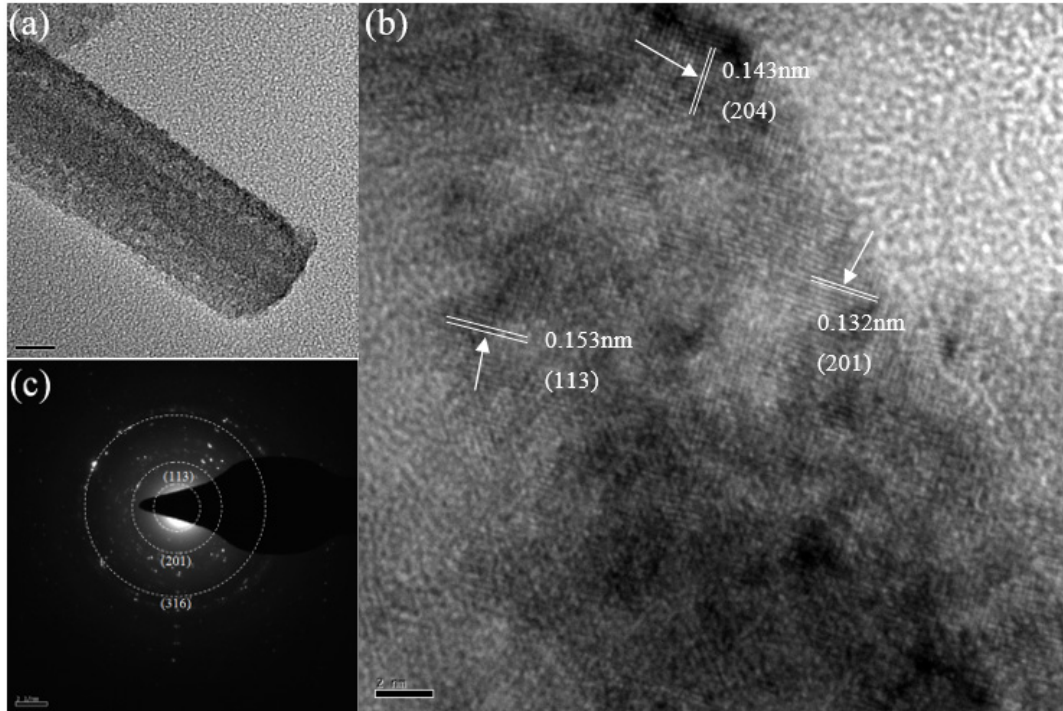
Figure 5 . ( a ) TEM image, ( b ) HRTEM image, and ( c ) SAED pattern of Ni 4 Co 4 Fe 2 -LDH/NF. The surface chemical state of Ni 4 Co 4 Fe 2 -LDH/NF was investigated by XPS technique (see Figure 6). As shown in Figure 6, XPS results confirm the presence of Ni, Co, and Fe on the film surface. The binding energy peaks of Ni 2p 3/2 , Co 2p 3/2 , and Fe 2p 3/2 are lo- cated at 856.4 eV, 782.2 eV, and 714.8 eV, respectively, indicating the +2, +3, and +3 oxida- tion states of Ni, Co, and Fe, respectively [39].